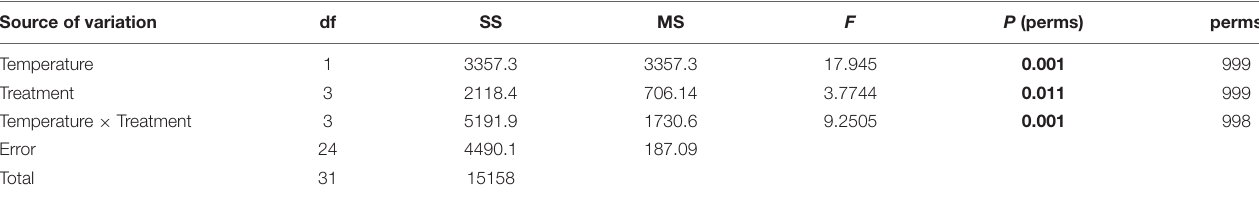
TABLE 2 | Results of the PERMANOVA testing the effects of the temperature (26 and 32 ◦ C) and treatments (Control, +Mn, +Fe, and +MnFe) on the levels of Hsp70, Hsp60, SOD, GR, and LPO obtained by permutations (perm) for each group. Source of variation df SS MS